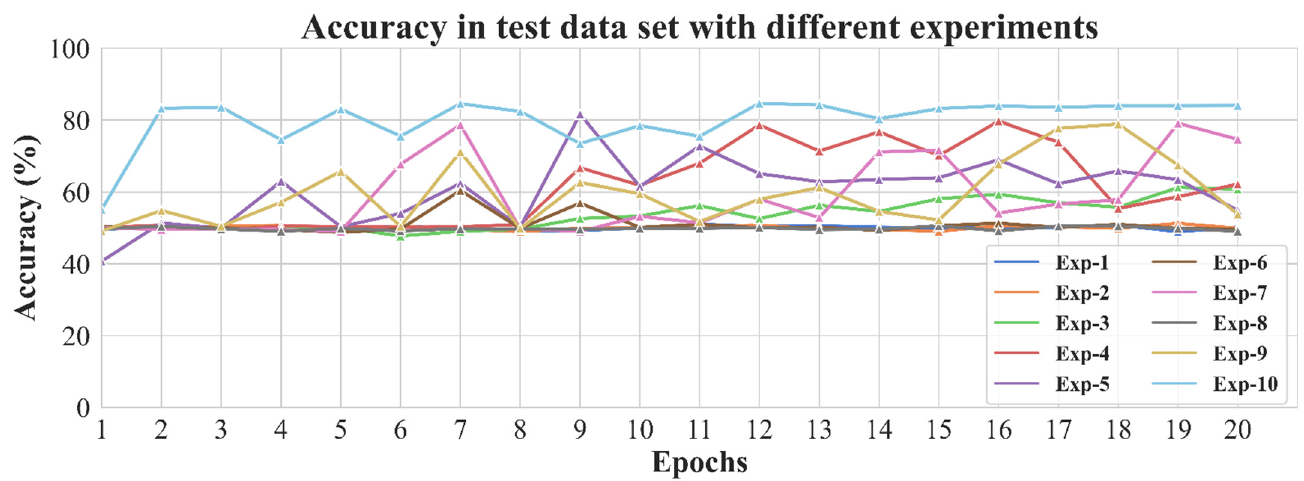
Figure 5. The accuracy of experiments with different parameters on the test dataset. Exp-1 was experiment-1 (Vgg-19, learning rate 0.1, without batch normalization, without pre-trained, without weight initialization). Exp-2 was experiment-2 (Vgg-19, learning rate 0.01, without batch normalization, without pre-trained, without weight initialization). Exp-3 was experiment-3 (Vgg-19, learning rate 0.01, with batch normalization, without pre-trained, without weight initialization). Exp-4 was experiment-4 (Resnet-18, learning rate 0.1, with batch normalization, without pre-trained, without weight initialization). Exp-5 was experiment-5 (Resnet-18, learning rate 0.01, with batch normalization, without pre-trained, without weight initialization). Exp-6 was experiment-6 (Resnet-18, learning rate 0.1, with batch normalization, without pre-trained, with weight initialization). Exp-7 was experiment-7 (Inception, learning rate 0.01, with batch normalization, without pre-trained, without weight initialization). Exp-8 was experiment-8 (Inception, learning rate 0.1, with batch normalization, without pre-trained, without weight initialization). Exp9 was experiment-9 (Resnet-18 with attention, learning rate 0.1, with batch normalization, without pre-trained, without weight initialization). Exp-10 was